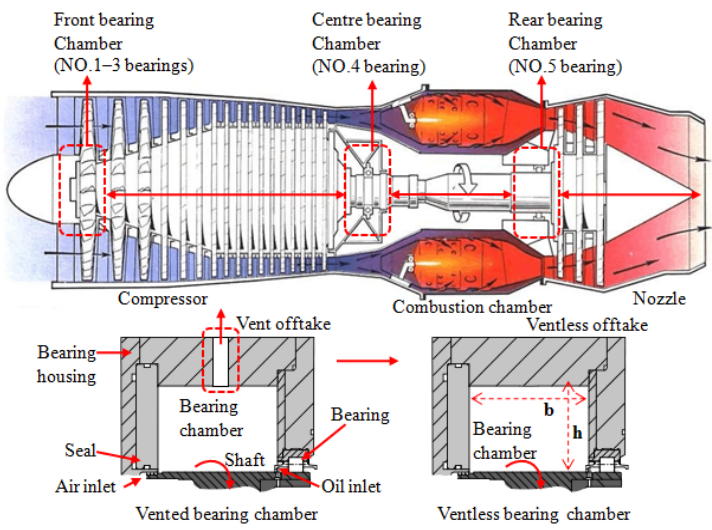
Figure 1. The positions of aero-engine bearing chamber and structural diagrams.